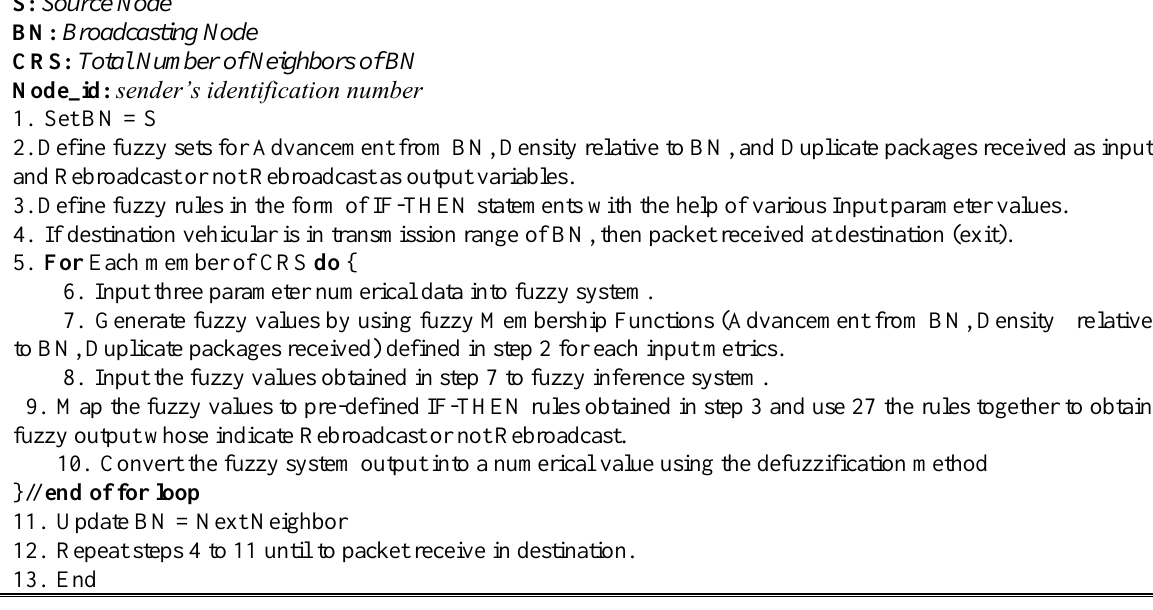
Algorithm 1: pseudo-code of proposed method (FLOR)